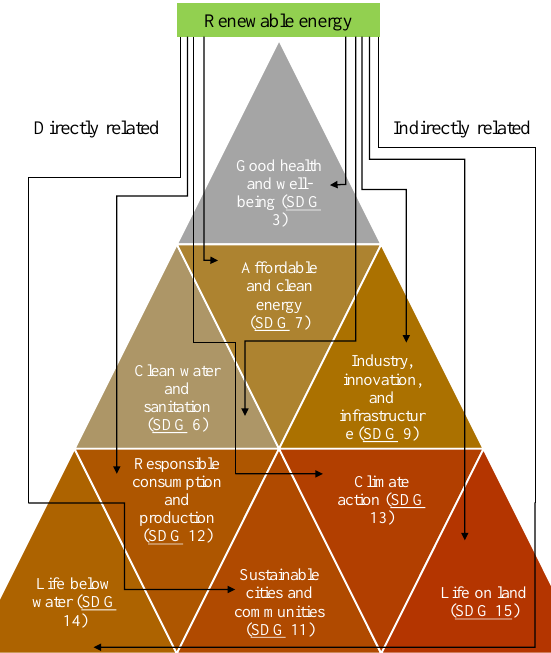
Figure 3. Renewable energy and related